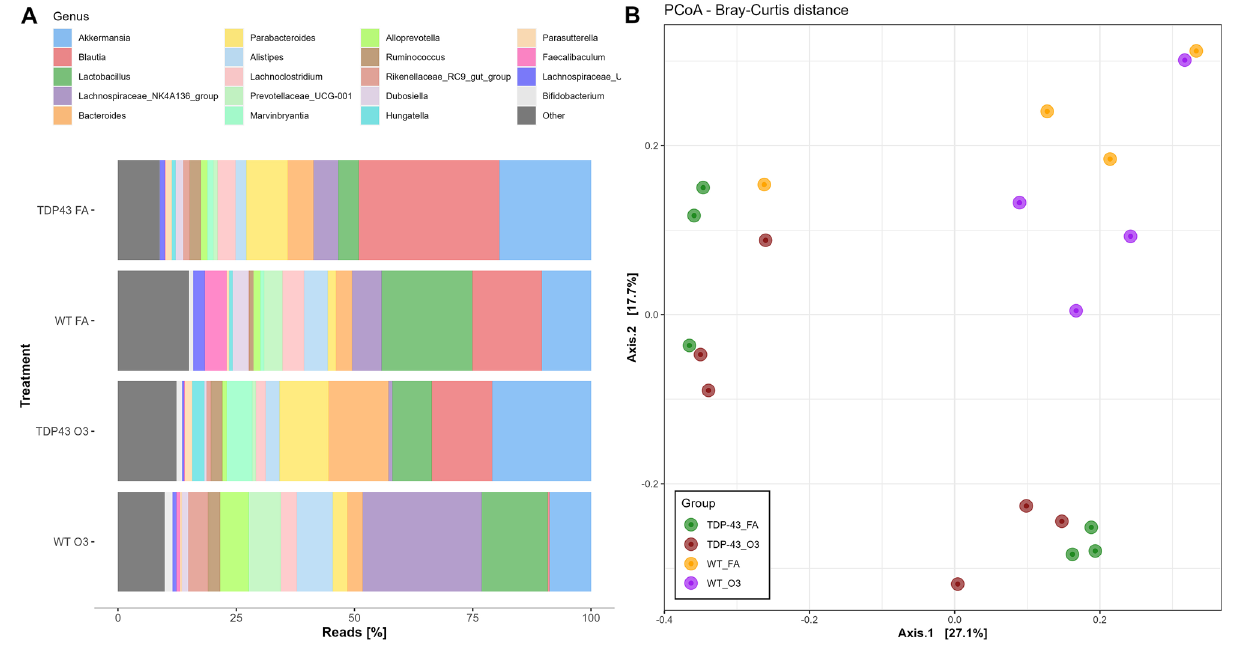
Figure 6. TDP-43 A315T mice develop gut microbiome compositional changes. ( A ) Relative abundance at genus level obtained by 16S rRNA amplicon sequencing. ( B ) Bray–Curtis PCoA at the end-stage of disease. Abbreviations: WT , Wild-type mice; TG , TDP-43 A315T mice; FA, filtered air; O 3,